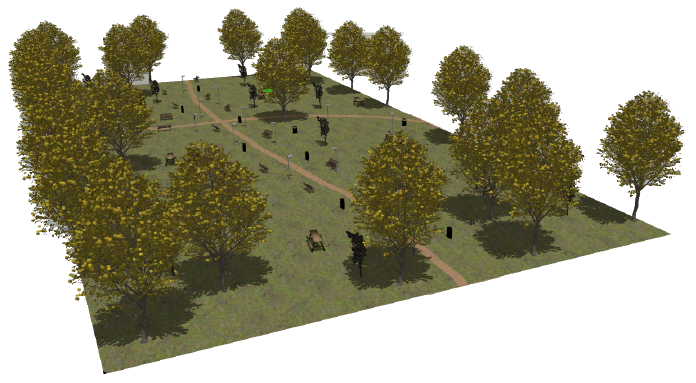
Figure 4. The urban park environment modeled in Gazebo.